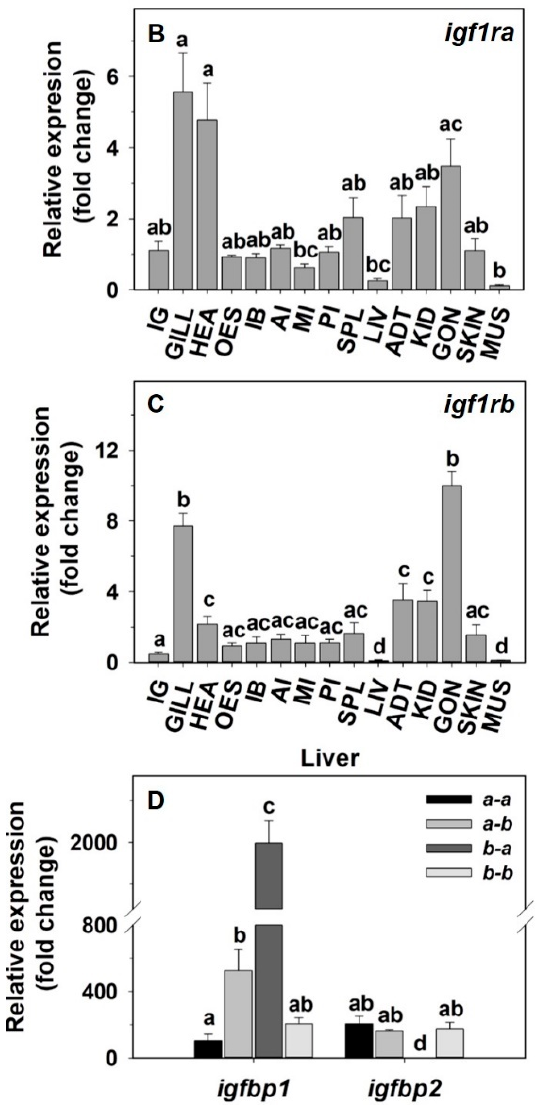
Figure 1. Tissue distribution of the IGF-1 system in peripheral tissues of goldfish. Relative expression of ( A ) igf-1 , ( B ) igf1ra , ( C ) igf1rb , ( D ) the four paralogs (a-a, a-b, b-a, b-b) of igfbp1 and igfbp2 in the liver. Data are expressed as mean ± s.e.m. ( n = 6) relative to the posterior intestine ( igf - 1 , igf1ra and igf1rb ). Different letters indicate statistical differences among tissues or subtypes. Interrenal gland (IG), gill (GILL), heart (HEA), esophagus (OES), intestinal bulb (IB), anterior intestine (AI), middle intestine (MI), posterior intestine (PI), spleen (SPL), liver (LIV), adipose tissue (ADT), kidney (KID), gonad (GON), skin (SKIN), muscle (MUS).